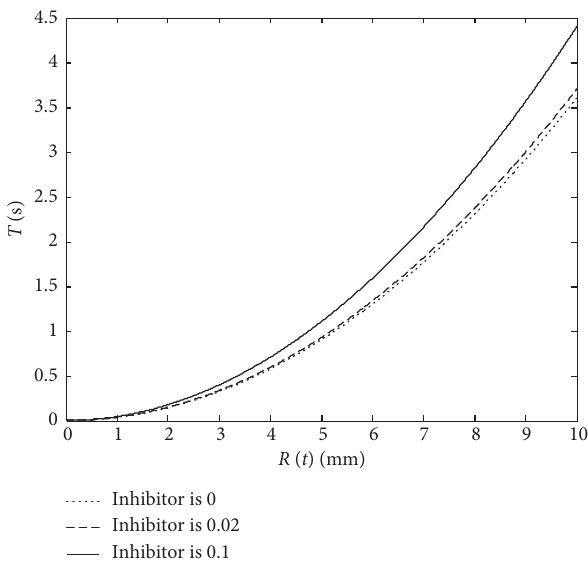
Figure 3: The trend of multiplication time T with R ( t ) under different inhibitor